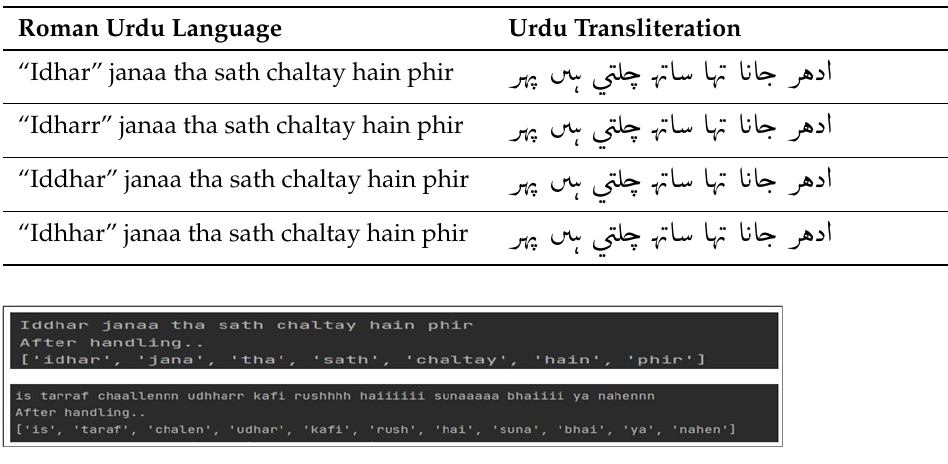
Figure 4. Colloquial variant handling in Roman Urdu language.